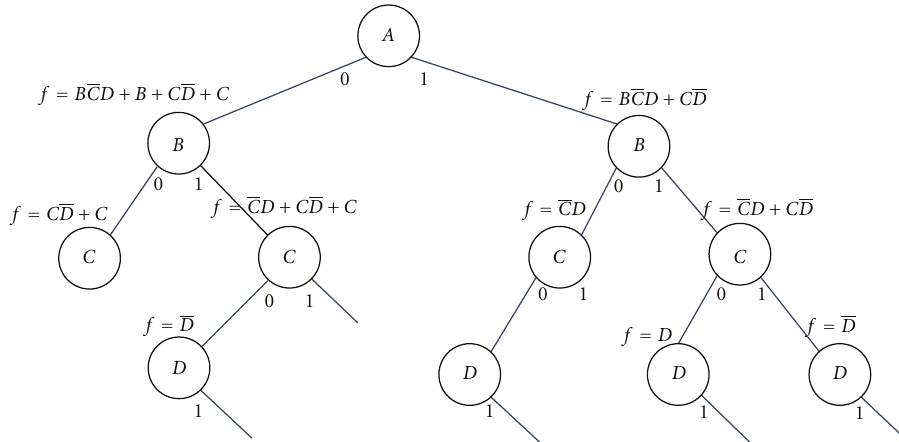
Figure 2: Boolean Decision Diagram for data represented by Table